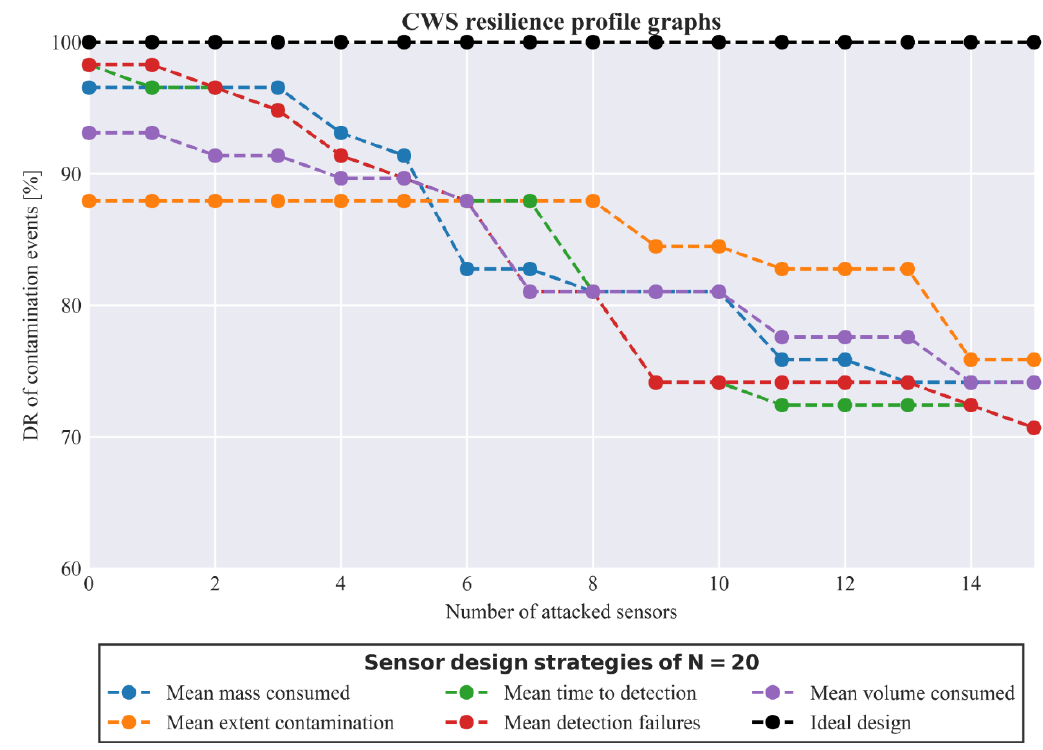
Figure 8. Resilience profile graphs for the five objective functions used to generate topologies of 20 sensors.